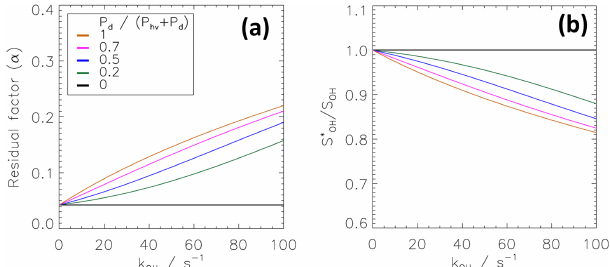
Figure 8. Calculated k OH dependence of the residual factor α and /S OH using a model that takes inhomogeneous mixing of ratio S ∗ OH the scavenger into account (see Sect. 4.3). The dependence is shown for different ratios of dark to total atmospheric OH production rates. The coloured horizontal lines denote the same ratios of dark to total OH production rates as used in Fig.